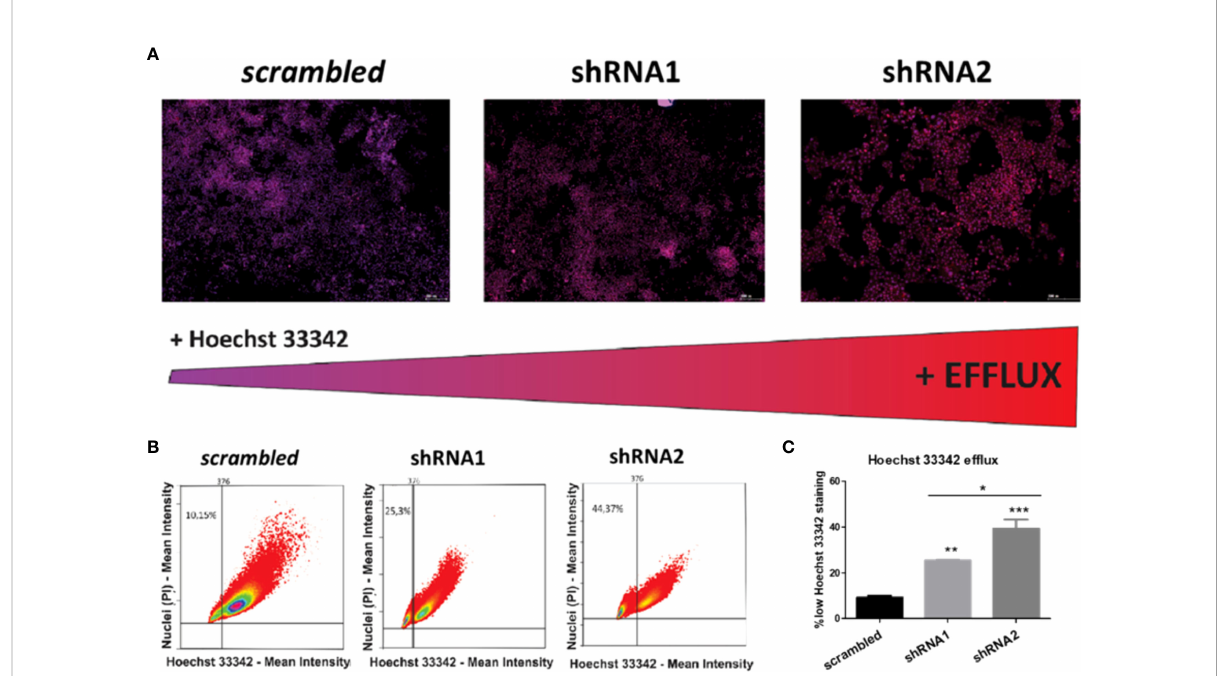
FIGURE 7 Effects of P2X7 receptor isoforms on the activity of drug ef fl ux pumps in NB cells. (A) Fluorescence microscopy images of ACN cells differently silenced for P2X7 receptor isoforms costained with PI (nuclear marker, red) and Hoechst 33342 (ef fl ux-prone dye, blue), obtained with a TissueFAXS ® fl uorescence microscope. Scale bars = 200 µM. The redness of cell nuclei is indicative of lower Hoechst 33342 staining and thus higher ef fl ux activity. (B) Dot plots quantifying the fl uorescence intensity of PI and Hoechst 33342 on P2X7 receptor isoform-silenced or nonsilenced ACN cells. Thresholds set based on negative and positive control samples select a low Hoechst 33342-stained population. (C) Percentages of ACN cell populations with high ef fl ux activity (low Hoechst 33342 staining). (n=3) *p<0.05; **p<0.01;